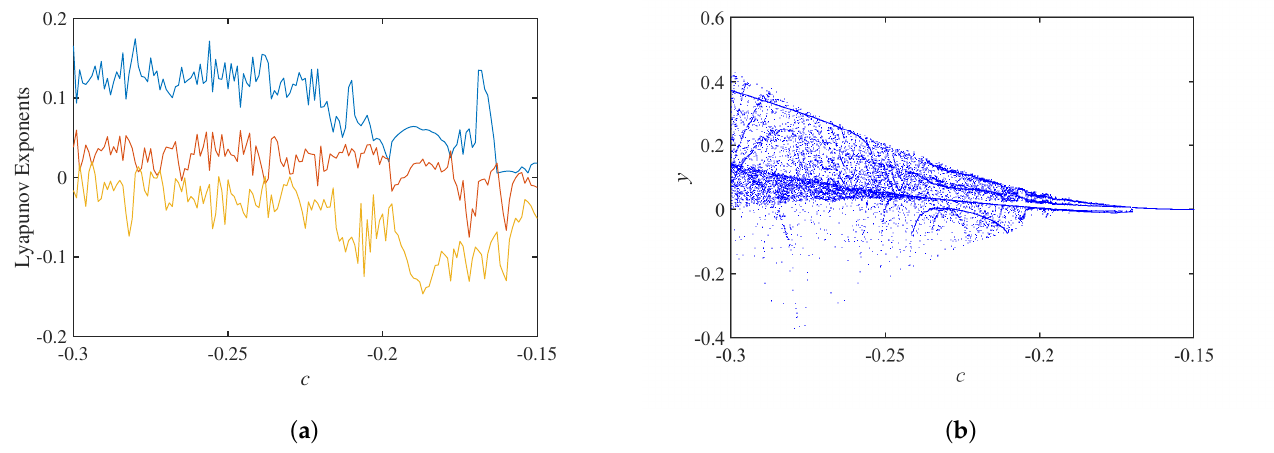
Figure 10. Dynamic analysis with parameter c : ( a ) Lyapunov exponents spectrum; ( b ) bifurcation